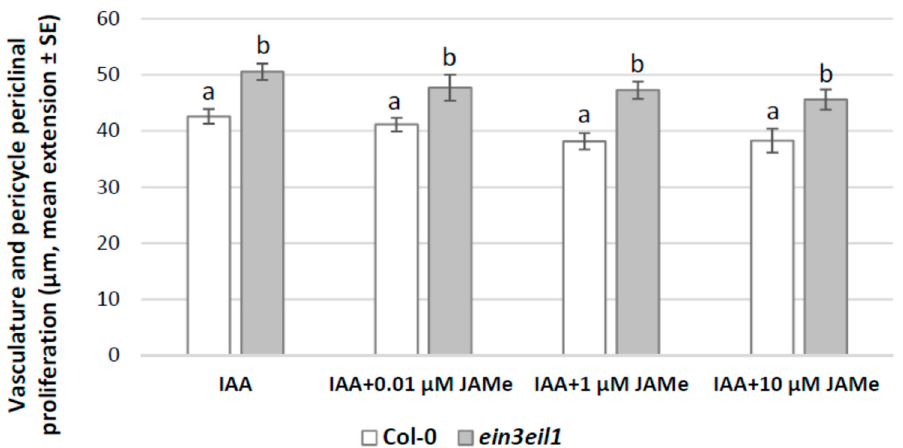
Figure 5. Pericycle periclinal proliferation in the basal hypocotyl of Arabidopsis Col-0 (wt) and ein3eil1 double mutant seedlings either cultured with IAA (10 µ M) or with IAA combined with 0.01, 1 or 10 µ M JAMe. Mean radial extension ( ± standard error (SE)) of the vasculature plus pericycle periclinal proliferation in the basal 5 mm of the hypocotyl. Different letters among different treatments within the same genotype, or between the two genotypes within the same treatment, indicate significant differences at least at p < 0.05. The same letters indicate no significant difference. Two-way ANOVA followed by Tukey’s post-test. n = 30.